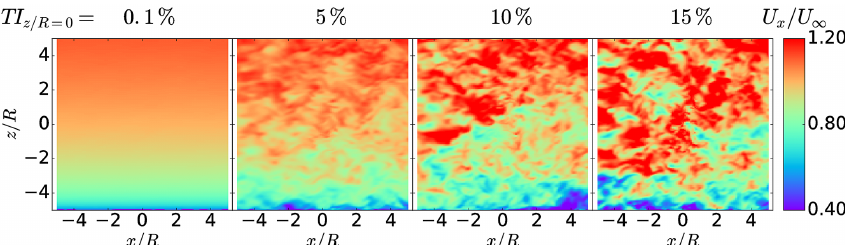
Figure 4. Vertical plane of the instantaneous axial velocity component U x in sheared flow for different longitudinal turbulence intensities TI z/R = 0 at hub